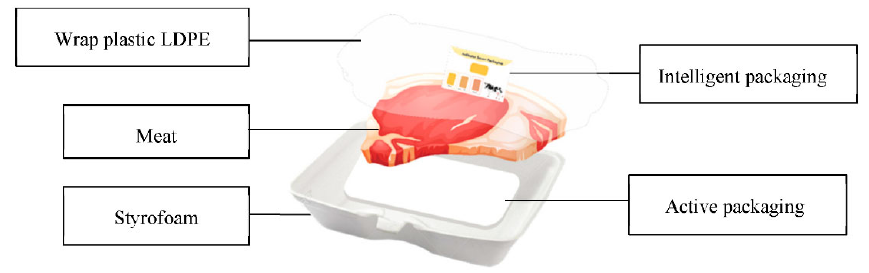
Figure 1. Design of the active packaging and intelligent